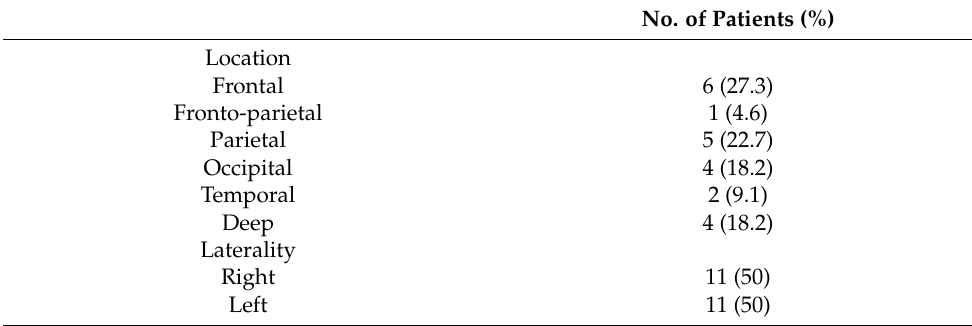
Table 2. Baseline radiological characteristics of brain arteriovenous malformations